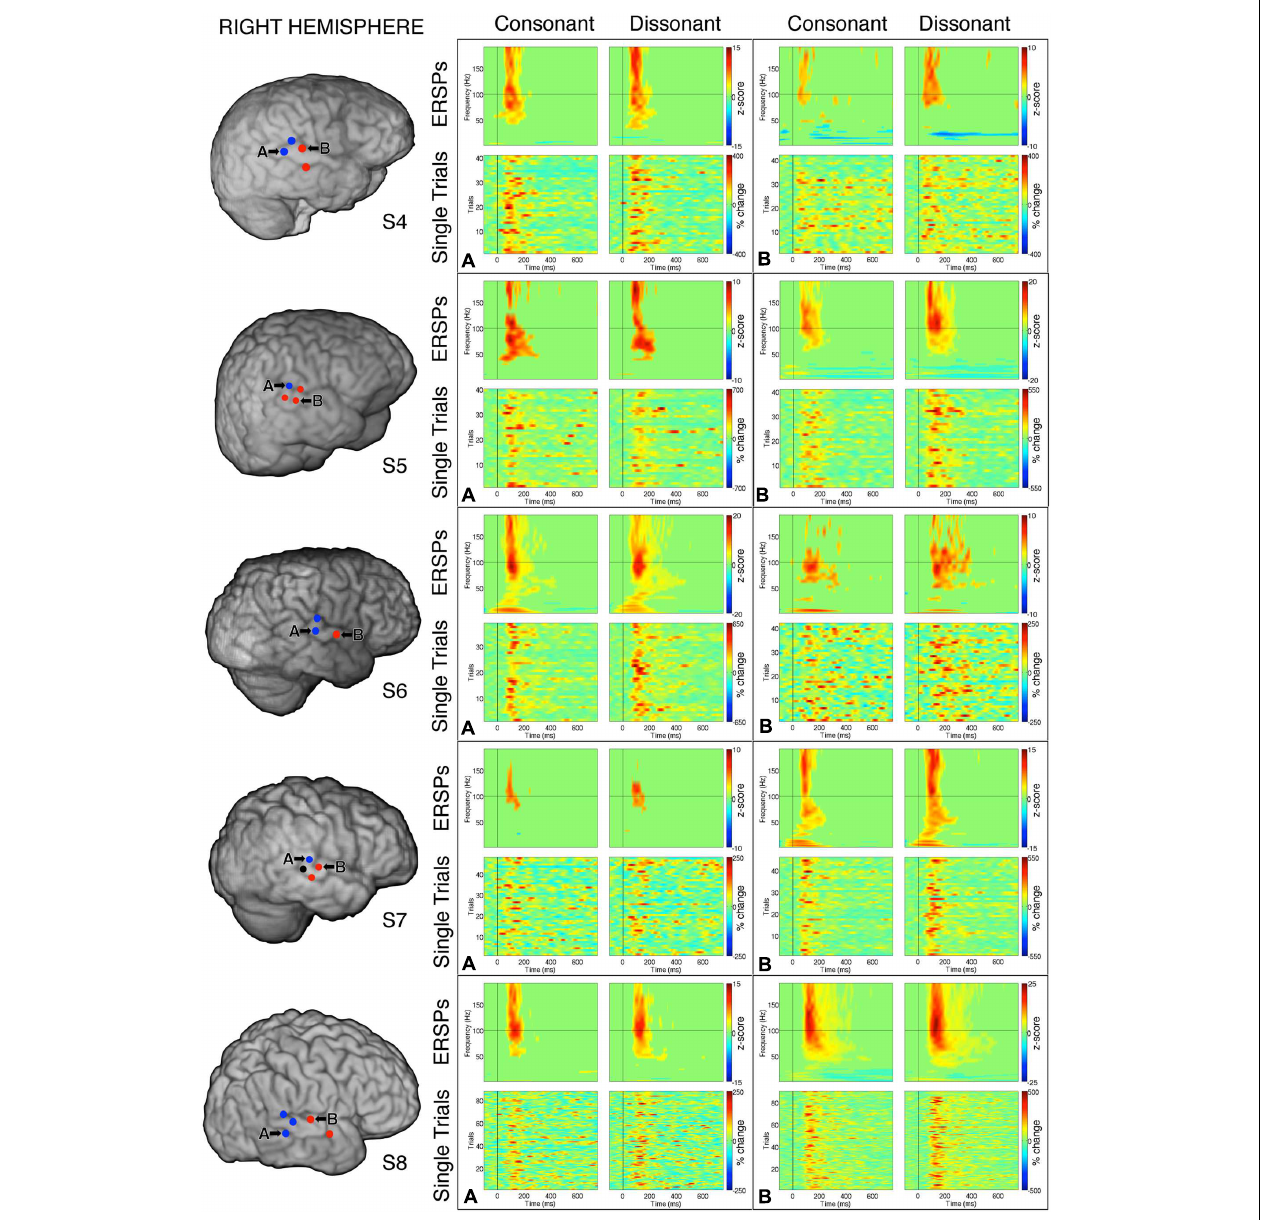
FIGURE 5 | Event-related spectral perturbations and Single Trial γ high responses to consonant vs. dissonant chords for one example electrode per response type (marked A and B respectively) for each subject with right hemisphere electrode coverage. All electrodes with significant γ high activity are included in individual subject brain images (left). The electrode marked ‘A’ in subject S7 met the statistical requirement to be categorized in the blue response type group, but was not included in the analysis because significant activation was less than 100 ms.